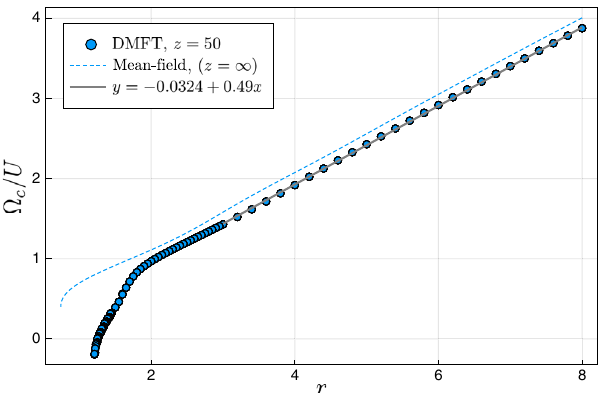
FIG. 13. Critical frequency for quantum synchronization Ω a function of the pump/loss ratio r , within DMFT NCA for connectivity z ¼ 50 and Gutzwiller mean-field theory ( z ¼ ∞ ). In the region of large drive, the fit shows that Ω agreement with the semiclassical result for the limit cycle in the VdP array. At lower drives, in the regimes of few bosons per site, quantum fluctuations become relevant and the critical frequency is strongly renormalized. Parameters: dim